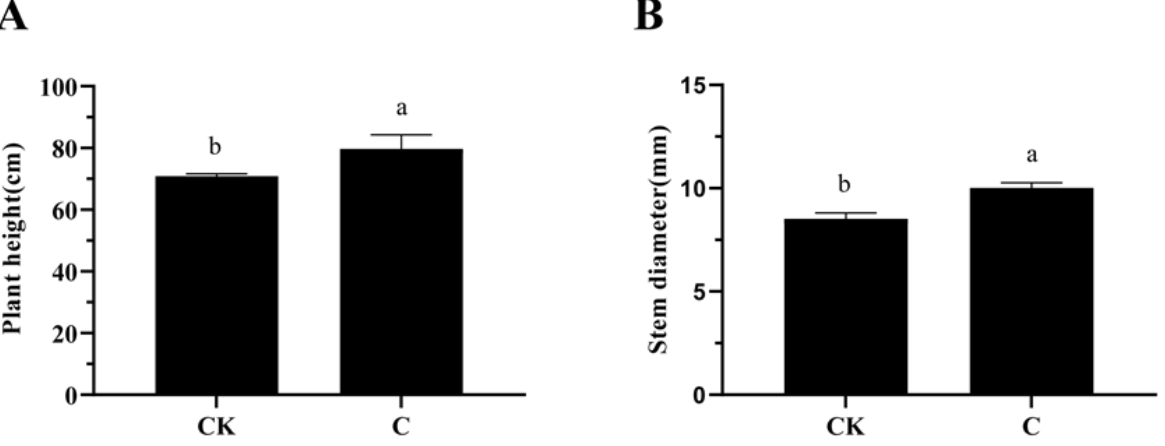
Figure 1. Effect of the GA 3 and ETH Treatment on Plant Growth. The application of GA 3 and ETH increased the plant height ( A ) and stem diameter of ramie ( B ). The values on the vertical axis represent the mean ± SE of three biological replicates in three plots. Different letters indicate significant differences at p < 0.05. SE, standard error.